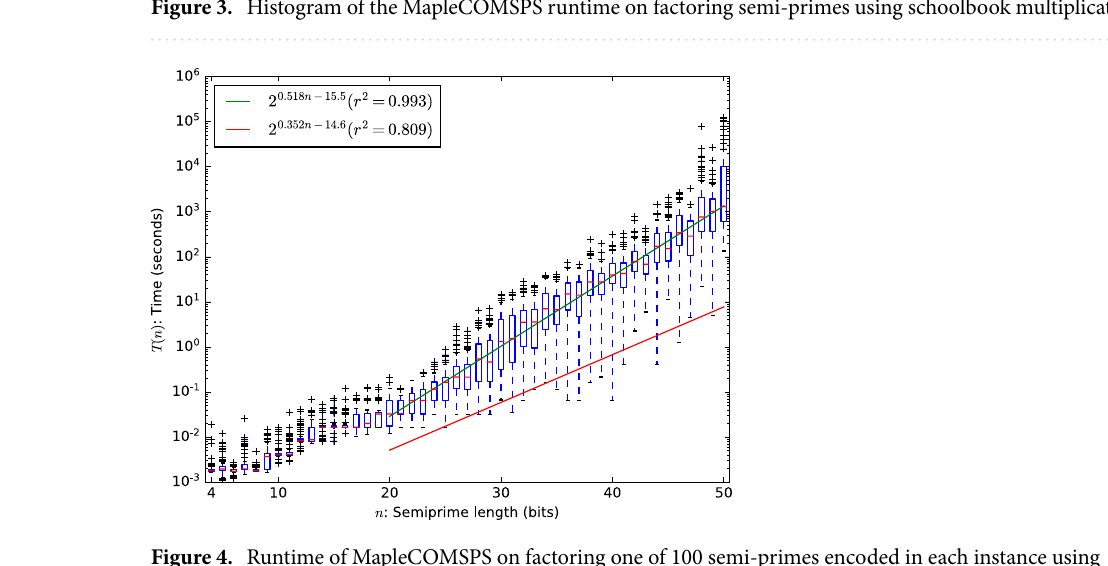
Figure 4. Runtime of MapleCOMSPS on factoring one of 100 semi-primes encoded in each instance using schoolbook multiplication.